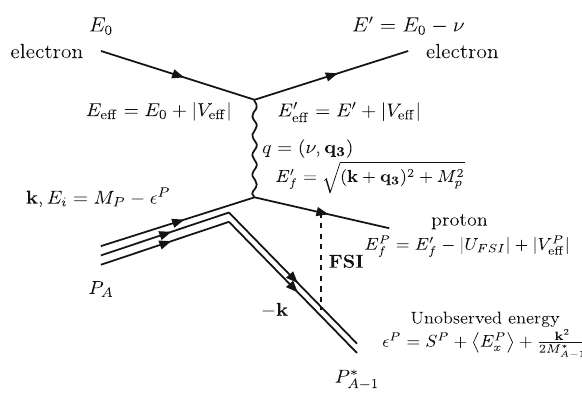
Fig. 3 1p1h process: Electron scattering from an off-shell bound pro- ton of momentum p i = k in a nucleus of mass A. Here, the nucleon is moving in the mean field (MF) of all the other nucleons in the nucleus. The on-shell recoil excited [ A − 1 ] ∗ spectator nucleus has a momentum p ( A − 1 ) ∗ = − k andameanexcitationenergy (cid:5) E P x (cid:6) .Theoff-shellenergy (cid:6) ( M ∗ ) 2 + k 2 = M − of the interacting nucleon is E i = M A − A − 1 A (cid:6) + E ) 2 + k 2 = M − (cid:2) P , where (cid:2) P = S P +(cid:5) E (cid:6)+ k 2 ( M . A − 1 x P x 2 M ∗ A − 1 WemodeltheeffectofFSI(strongandEMinteractions)bysetting E f = (cid:6) ) 2 + M 2 −| U |+| V P | ,where U = U (( q + k ) 2 ) . ( k + q 3 FSI FSI FSI 3 P ef f | For electron QE scattering on bound protons | V P ef f